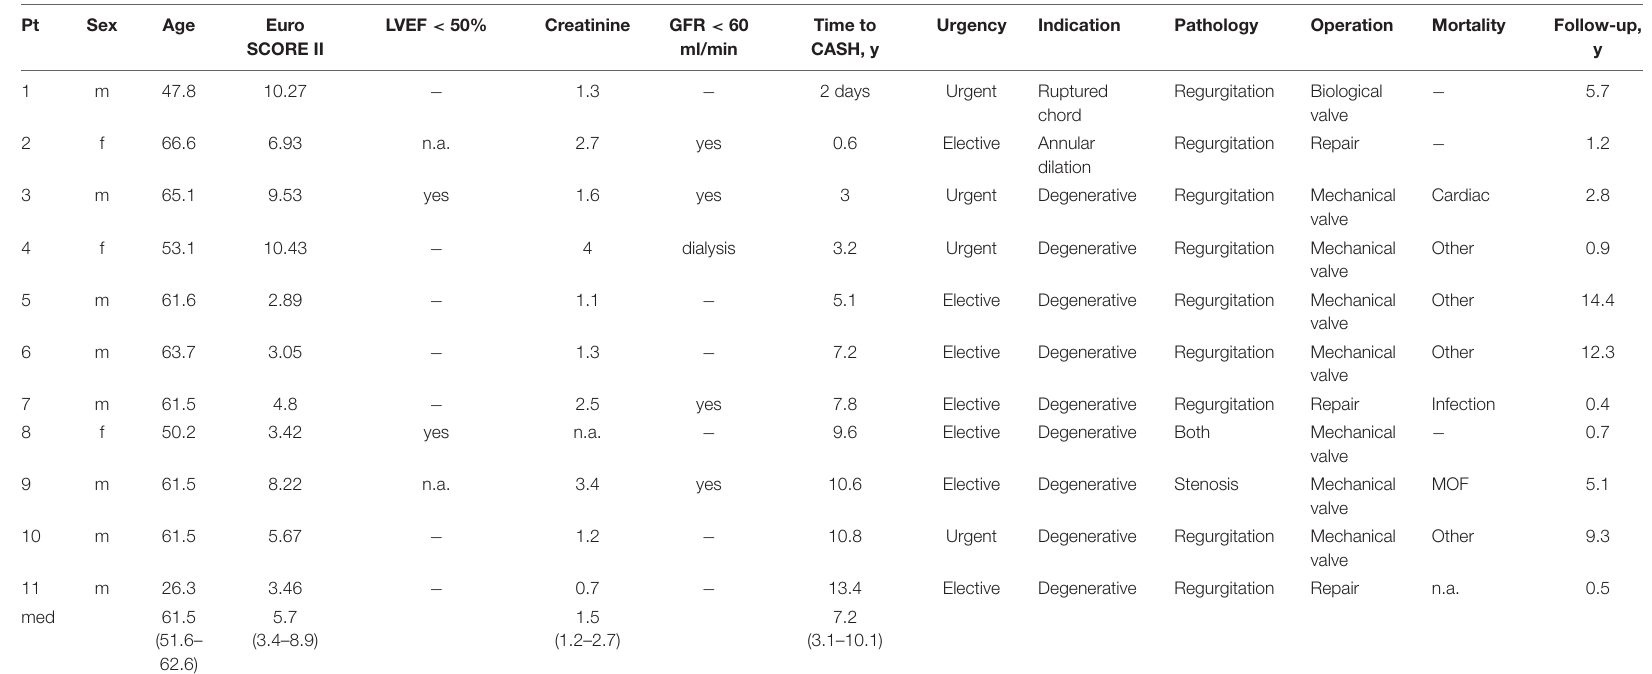
TABLE 3 | Mitral valve